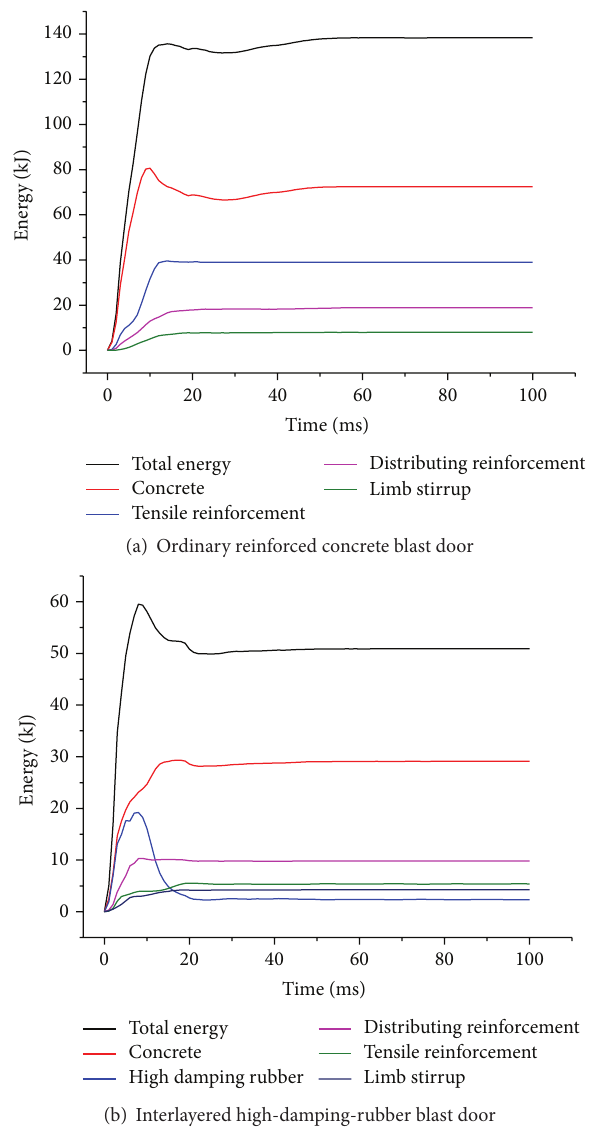
Figure 10: Distribution of energy of blast